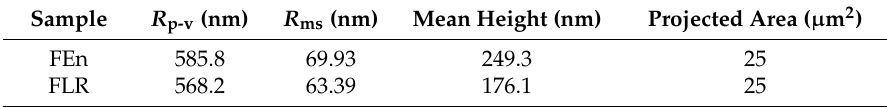
membranes, as observed via AFM.